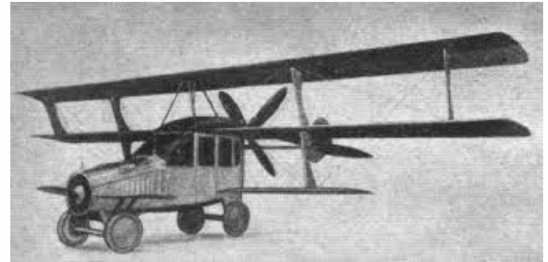
Figure 1. Curtiss Autoplane